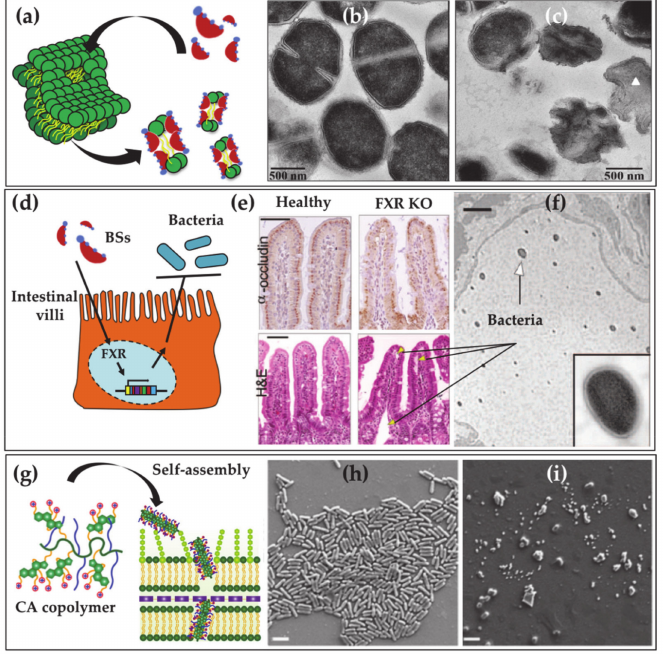
Figure 3. ( a ) Direct antimicrobial mechanism of natural BA: detergent effect of BA on the bacterial membrane. Transmission Electron Microscopy images of S. aureus before ( b ) and after ( c ) the interaction with glycocholic acid (GCA) (Sannasiddappa, T.H.; Lund P.A.; Clarke S.R. In Vitro Antibacterial Activity of Unconjugated and Conjugated Bile Salts on Staphylococcus aureus . Front. Microbiol. 2017 , 8 , 1581 [99] copyright © 2017 Sannasiddappa, Lund, Clarke (CCBY)) ( d ) Indirect antimicrobial mechanism of natural BA: BAs activate the farnesoid X receptor (FXR) that in turn induces the expression of genes producing toxic molecules for bacteria (Inagaki, T.; Moschetta, A.; Lee, Y.K.; Peng, L.; Zhao, G.; Downes, M.; Yu, R.T.; Shelton, J.M.; Richardson, J.A.; Repa, J.J.; et al. Regulation of Antibacterial Defense in the Small Intestine by the Nuclear Bile Acid Receptor. Proc. Natl. Acad. Sci. USA 2006 , 103 , 3920–3925. Ref. [64], Copyright (2006) National Academy of Sciences, U.S.A.). ( e ) Transverse sections of terminal ileum of mice immunostained with anti-occludin antisera (top) and hematoxylin and eosin (H&E, bottom), scale bar 50 µ m. Micrographs of control mice (left) are contraposed to micrographs of FXR knockout mice (right). ( f ) Lymphatic vessel section of FXR knockout mice, scale bar 2 µ m. Arrows point to traces of edema and dilated lymphatic vessels that are induced by bacteria. ( g ) Copolymers of cholic acid (CA) and polyethylene glycol self-assemble into rods that are able to penetrate the bacterial membrane Scanning Electron Microscopy images of E.coli without ( h ) and with ( i ) BA polymer treatment (adapted with permission from Rahman, M.A.; Jui, M.S.; Bam, M.; Cha, Y.; Luat, E.; Alabresm, A.; Nagarkatti, M.; Decho, A.W.; Tang, C. Facial Amphiphilicity-Induced Polymer Nanostructures for Antimicrobial Applications ACS Appl.